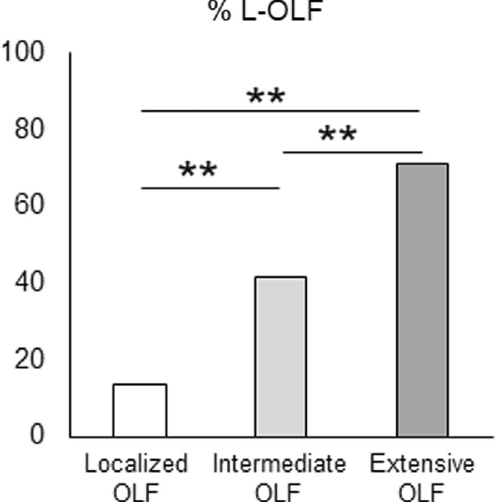
Figure 3. Comparison of comorbidity of lumbar OLF among the three OLF categories (localized OLF, OLF index ≤ 2; intermediate OLF, 3 ≤ OLF index ≤ 5; extensive OLF, 6 ≤ OLF index ≤ 12). * P < 0.01, ** P < 0.001. OPLL ossification of the posterior longitudinal ligament, OLF ossification of the ligamentum flavum, L